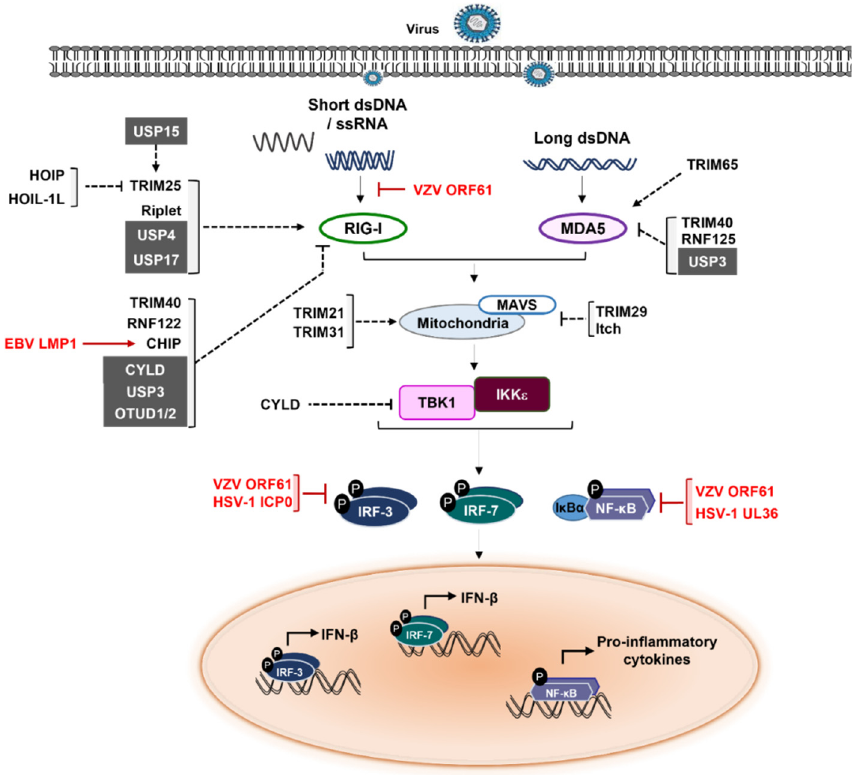
Figure 1. Immune evasion strategies of herpesviruses regarding E3s and DUBs in RLR-mediated signaling cascades. RIG-I recognizes and binds to ssRNA bearing a 5 (cid:48) -triphosphate moiety, as well as short dsRNA, leading to a conformational change that exposes CARDs. RIG-I then binds MAVS through CARD–CARD interaction. After MAVS oligomerization, it then activates IRF3/7- and NF- κ B- mediated signaling by recruiting TRAFs, leading to the production of type I IFN and pro-inflammatory cytokines. The words in red color indicate herpesviruses proteins. The gray boxes represent cellular DUBs. Solid lines represent RLR-mediated signaling pathway. The dashed lines indicate effects of cellular E3 ubiquitin ligases (or DUBs) on molecules in RLR-mediated signaling